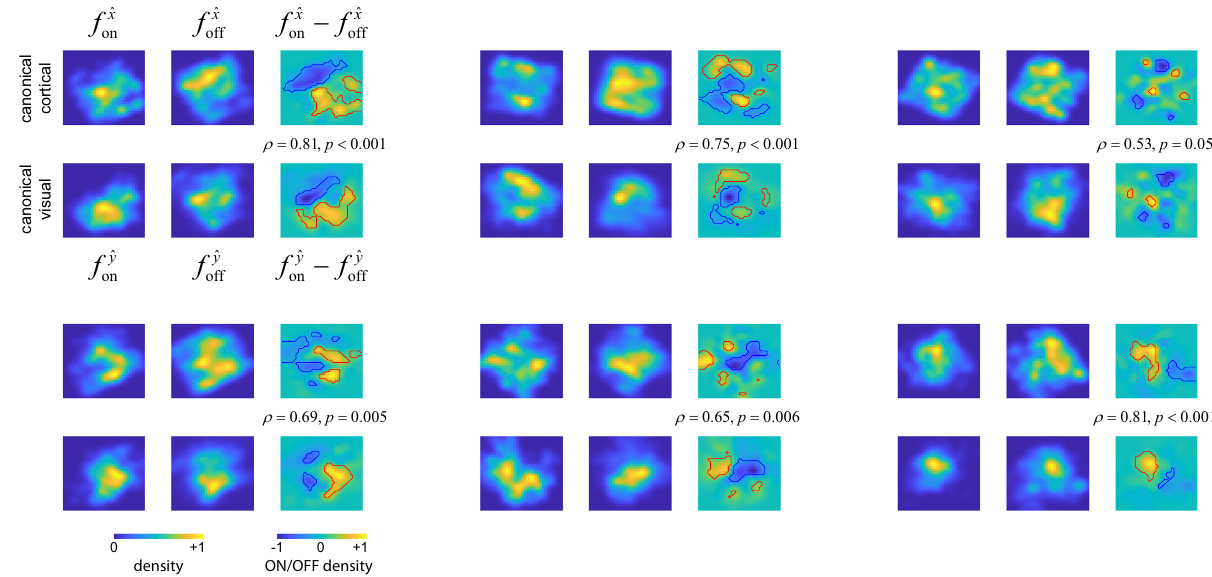
Fig. 5 Correlation between ON/OFF domains and fl uctuations in the balance of ON/OFF representation at the input. Each panel displays the result of one experiment. In each case, the top row displays the density of ON ( f x f x (cid:2) f x . The bottom row shows the density in the position of receptive fi eld centers for ON ( f y on off (cid:2) f y their difference, f y . In all panels, both axes span the range from − 2.5 to 2.5. Level sets showing areas where fl uctuations are above or below the on off expected at the p = 0.001 signi fi cance level are shown by red and blue solid curves (Monte Carlo simulations with random shuf fl ing of the ON/OFF labels in the population). The correlation coef fi cient between the fl uctuations f x reached in each case (N = 1000 Monte Carlo simulations with reshuf fl ing of ON/OFF labels). In each panel, the distributions are normalized by their maximum value and the colormap ranges from 0 to 1 (bottom left), while the differences of the distributions are shown normalized to their maximum absolute value, with the colormap ranging from − 1 to